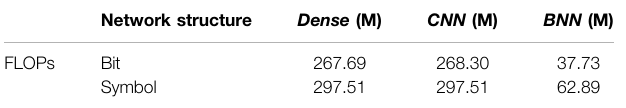
TABLE 2 | Computational complexity of networks. Network